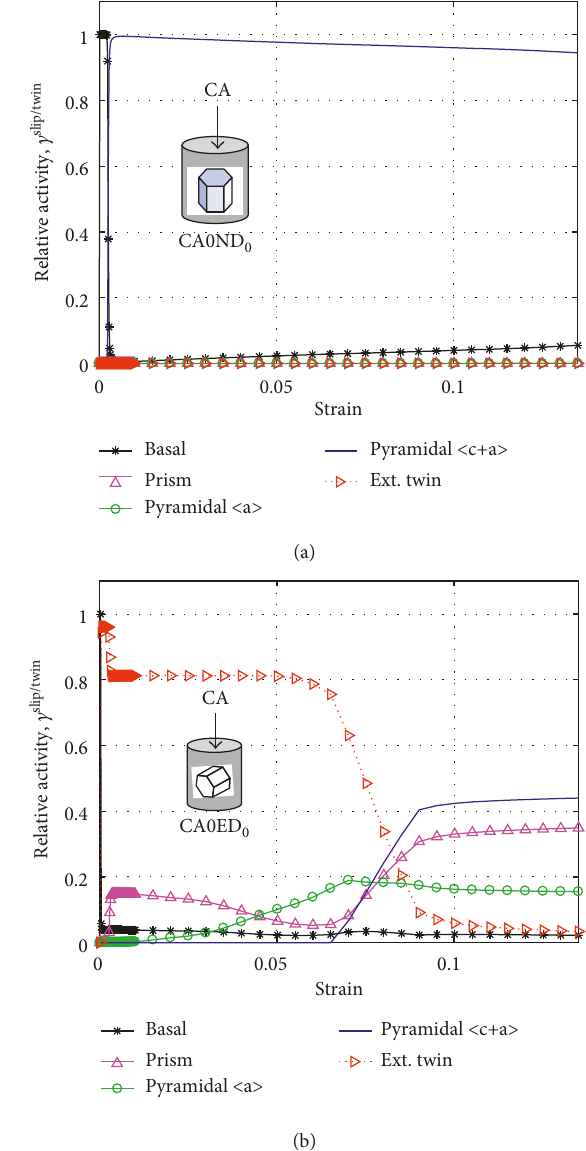
Figure 9: Relative slip and twin activities predicted by crystal plasticity simulation during plane strain compression of pure Mg for the two sample orientations tested in this study: (a) ND90ED 0 sample (ND ‖ c -axis) and (b) ND0ED 0 sample (ND ⊥ c -axis).